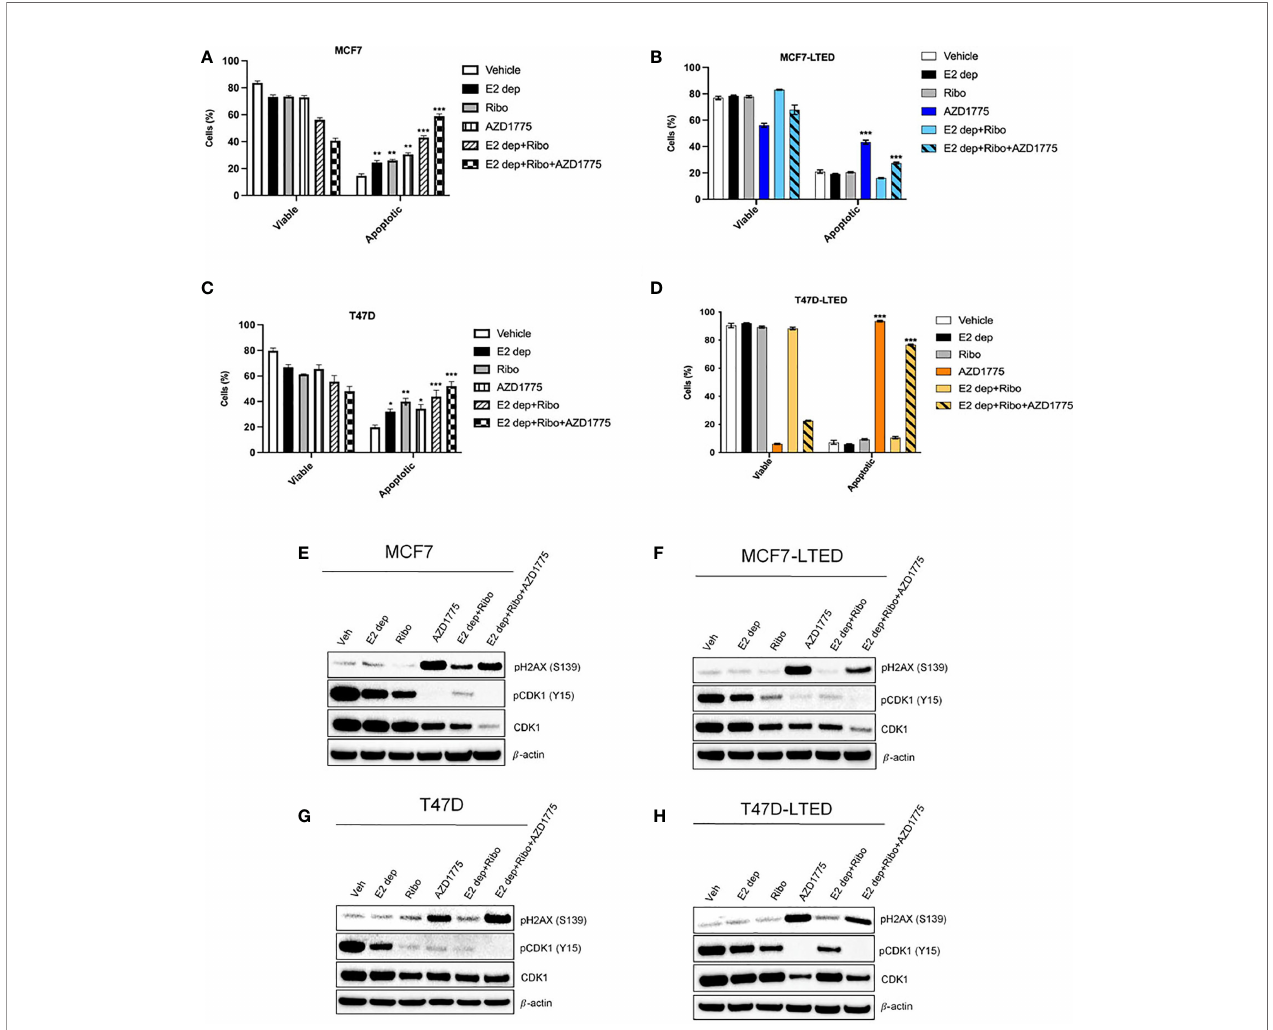
FIGURE 8 | AZD1775 induced marked increase in apoptosis in LTED cells. (A – D) Parental MCF7 and T47D cells and their corresponding LTED derivatives were treated with vehicle, E2 deprivation (E2 dep), 500nM ribociclib (ribo), 500nM AZD1775 alone or the combination of E2 dep, ribo or the triple combination of E2 dep, ribo and AZD1775 for 6 days. Annexin V-FITC assay was used to measure apoptosis levels. *p < 0.05, **p < 0.01 and ***p < 0.001 (ANOVA) for % apoptotic cells with different treatment conditions compared with vehicle alone for respective cell lines. (E – H) Cells were treated with indicated treatments for 6 days. Whole cell lysates were subjected to immunoblotting with indicated antibodies; b -actin was used a loading control. All blots and proliferation assays are from three independent experiments